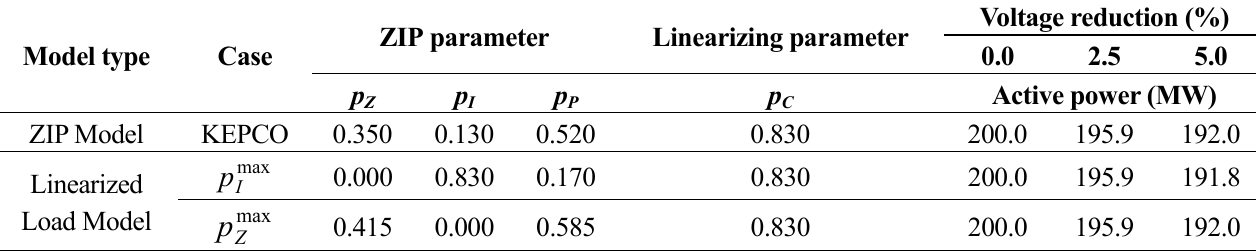
Table 1. Active power variations due to voltage reductions with different active ZIP